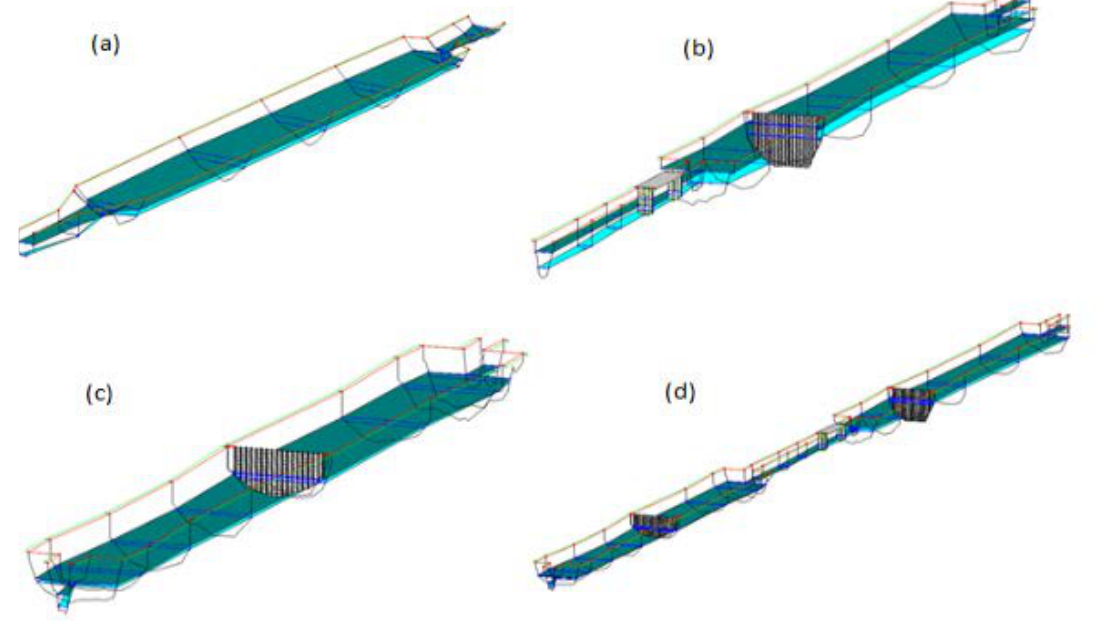
Figure 3. Hydraulic models for (a) Basin A; (b) Basin B1; (c) Basin B2; and (d) Basins B1–B2 (in series), showing the lowest (cyan) and highest (green) simulated water